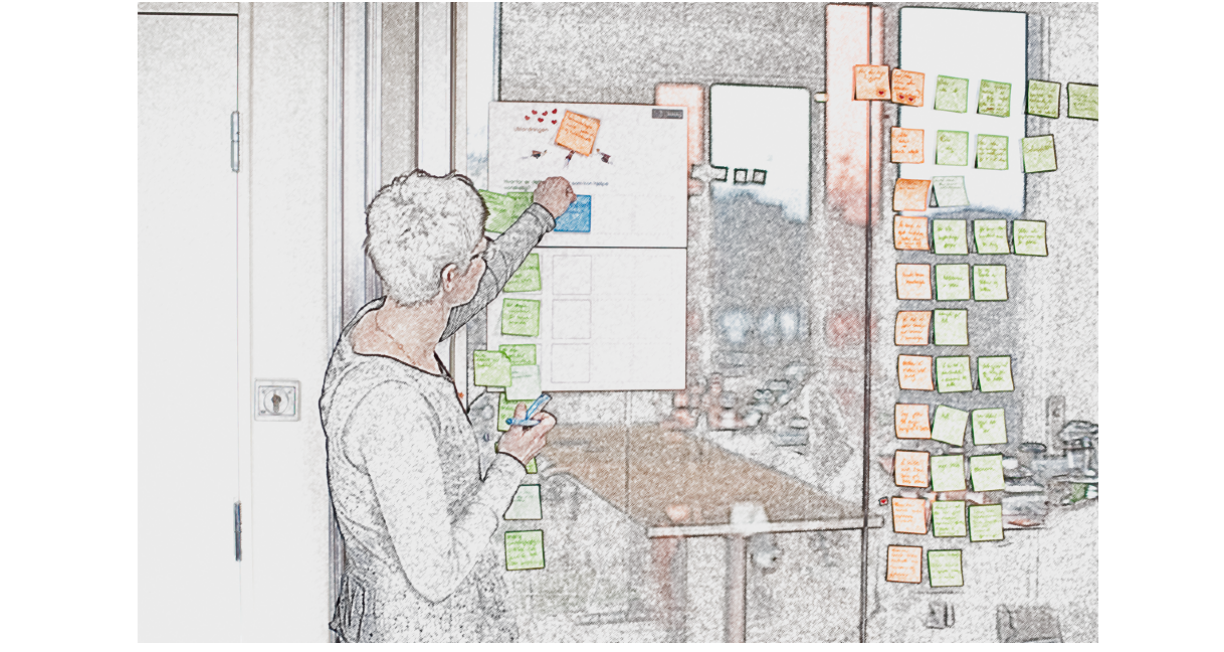
Figure 2. Activity from Idea Generation